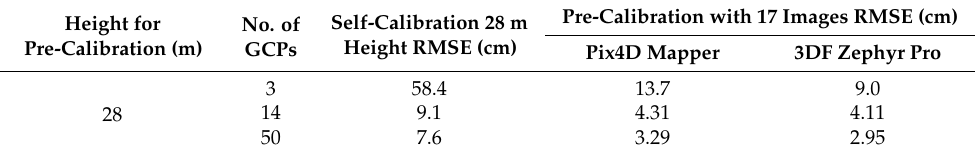
Table 7. The residuals of 100 CPs for a 28 m nadiral flight when using self-calibration and pre-calibration at 28 m height done with “Pix 4D Mapper” respectively “3DF Zephyr”.